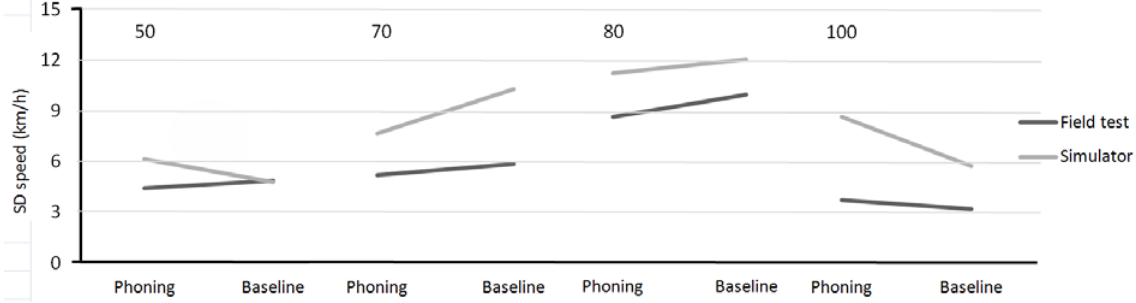
Figure 5b. Speed variation results from the cognitive distraction data, per speed limit. Only the interaction for 100 km/h speed limit was significant at